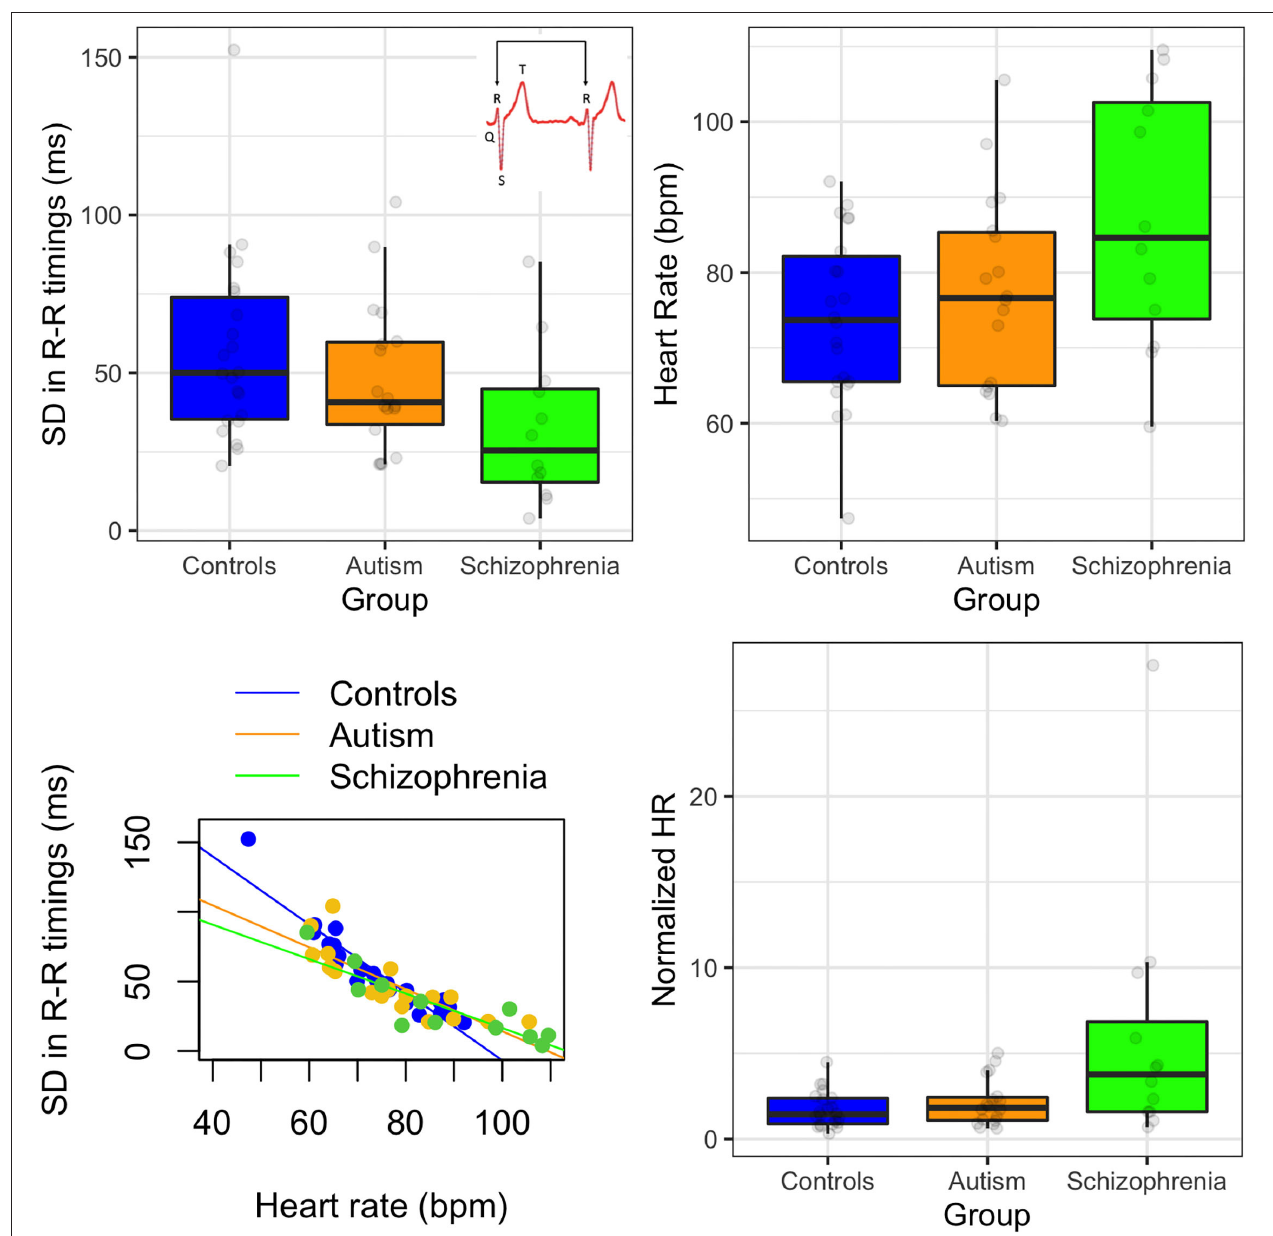
FIGURE 1 | (Top left) Standard deviation in R-R peak timings in controls, autism, and schizophrenia; insert showing an example waveform with labeled peaks. (Top right) Heart rate in beats per minute (bpm) for each group. (Bottom left) relationship between heart rate and standard deviation in R-R timings. (Bottom right) normalized heart rate by variability for each group. Error bars show 95% confidence